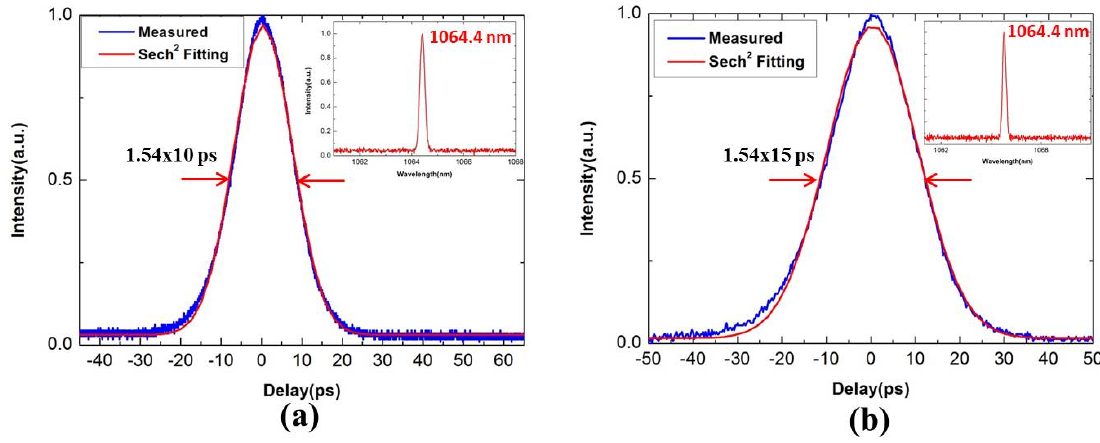
Figure 2. ( a ) Mode-locked pulse trains; and ( b ) power stability curve of the picosecond oscillator.